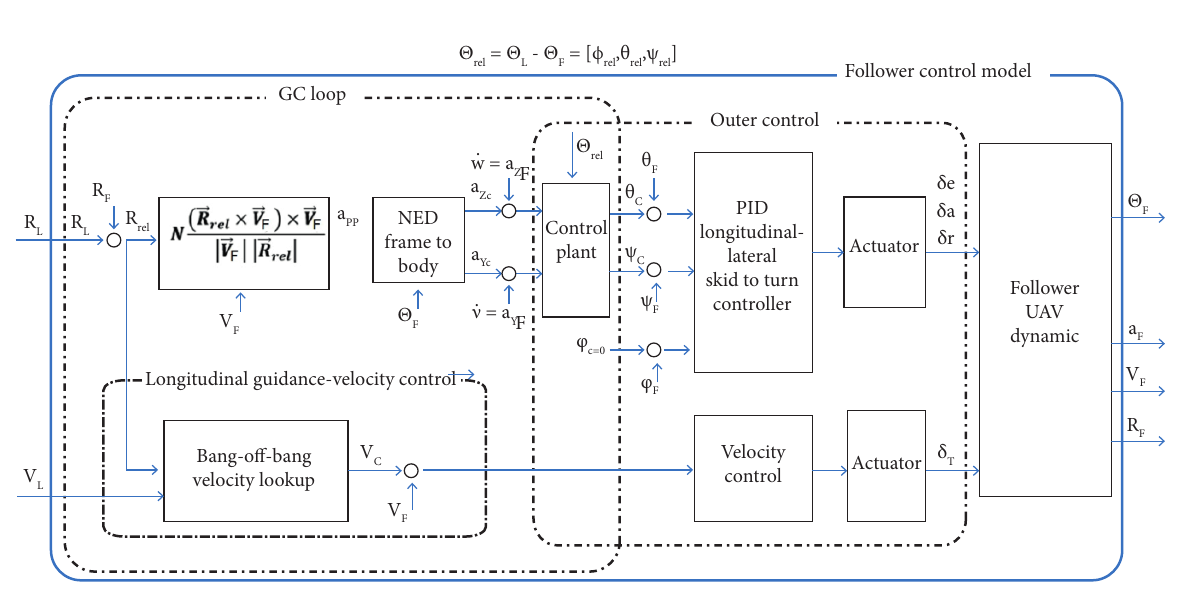
Figure 6. Follower’s connection